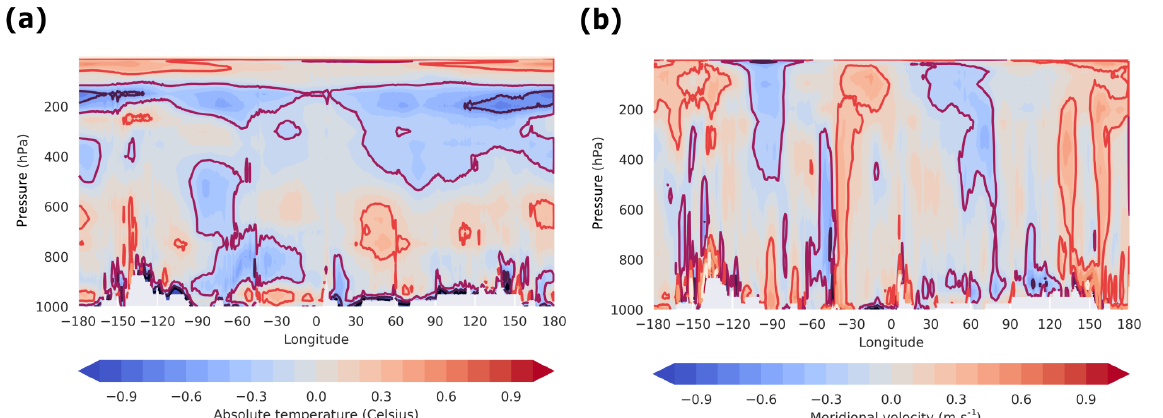
Figure 5. Difference in temperature, meridional wind velocity and temperature transport between MERRA-2 and ERA-Interim at 60 ◦ N. The vertical profiles of (a) temperature difference and (b) meridional wind velocity difference are calculated from the climatology of each field from 1994 to 1998, respectively.